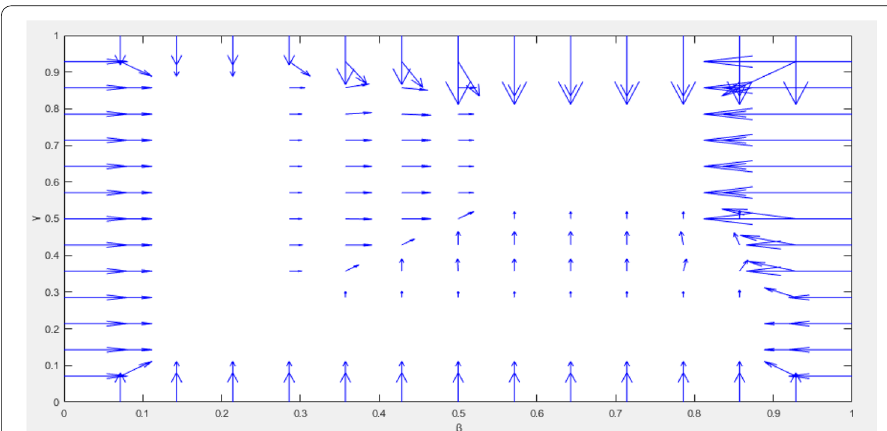
Fig. 8 Model dependency γ and β on the security risk